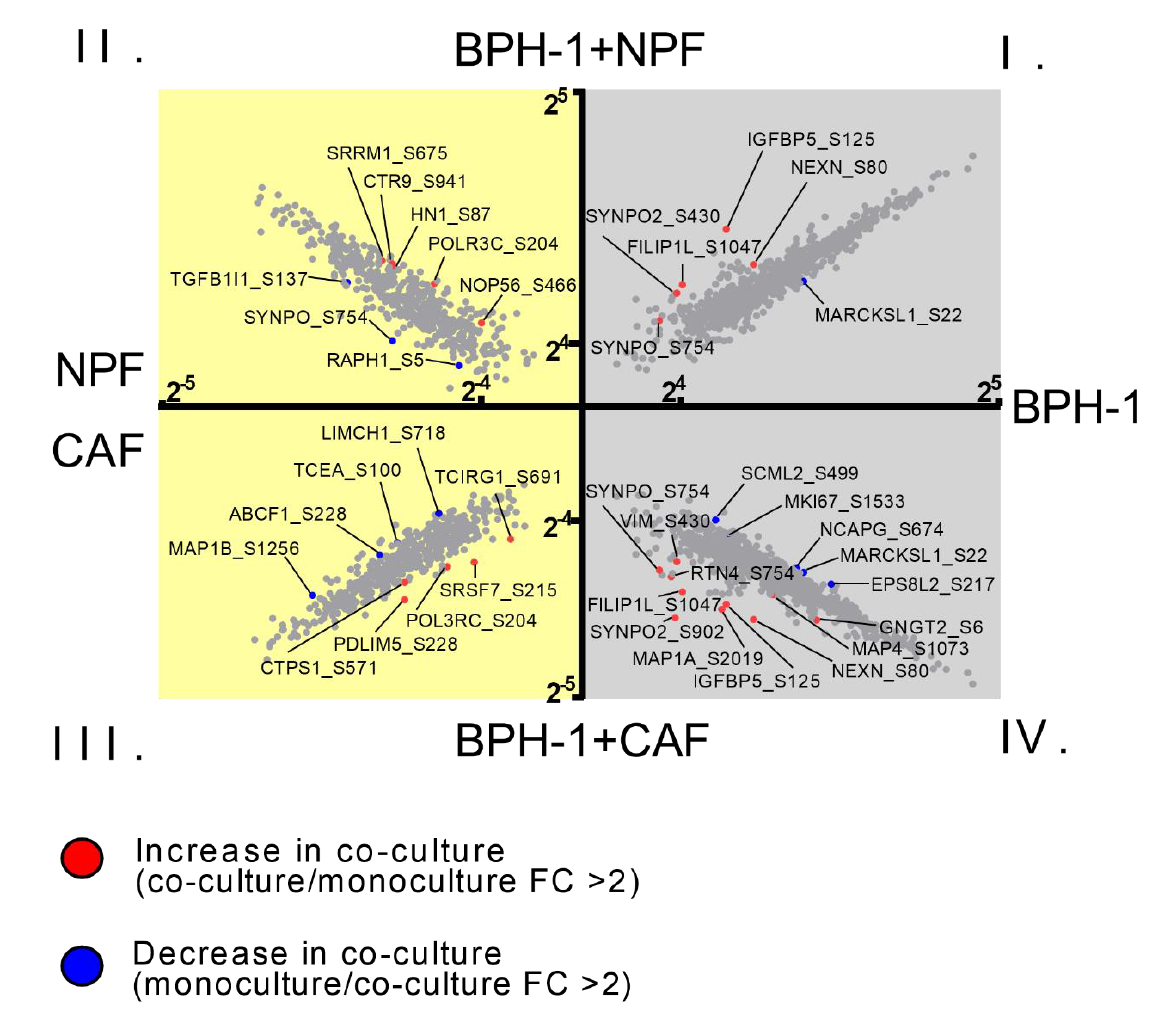
Figure 4. X-plot of differentially abundant phosphosites in BPH-1/fibroblast co-culture compared to monoculture. Scatter plots representing mean log2-transformed phosphosite abundance; x -axis represents abundance in monoculture, and y -axis represents abundance in co-culture. Significantly upregulated phosphosites (red dots; phosphosite level in co-culture/corresponding monoculture) and downregulated phosphosites (blue dots; phosphosite level in monoculture/corresponding co-culture) in co-culture were selected using a cut-off value of FC > 2. Phosphosites closer to the y -axis (red) represent a significant increase of expression, while phosphosites closer to the x -axis (blue) represent a decrease of expression upon co-culture. Grey background: BPH-1 phosphosite levels, yellow background: fibroblast phosphosite levels. Quadrant I: BPH-1 phosphoproteins in monoculture compared to BPH-1 phosphoproteins in co-culture with NPFs, Quadrant II: NPF phosphoproteins in monoculture compared to NPF phosphoproteins in co-culture with BPH-1 cells, Quadrant III: CAF phosphoproteins in monoculture compared to CAF proteins in co-culture with BPH-1 cells, Quadrant IV: BPH-1 phosphoproteins in monoculture compared to BPH-1 phosphoproteins in co-culture